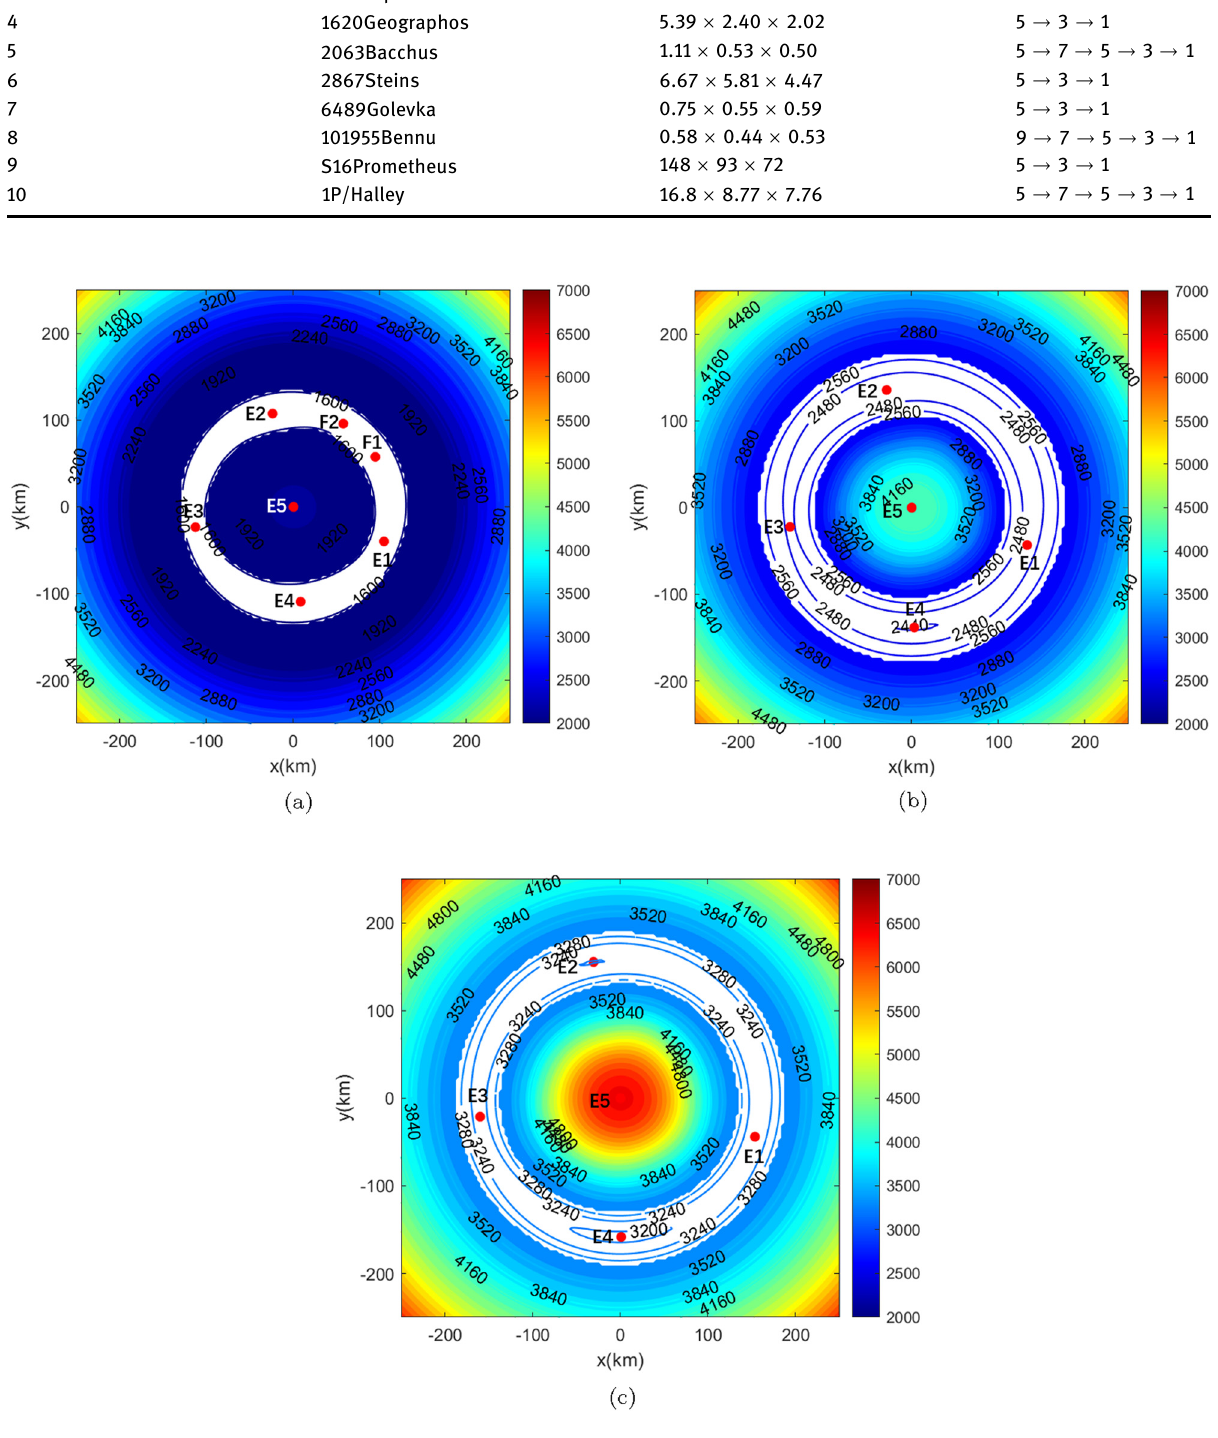
Figure 6: The projection of the equilibrium points of asteroid Minerva in the z + view and the contour map of the zero - velocity surface under di ff erent densities. ( a )